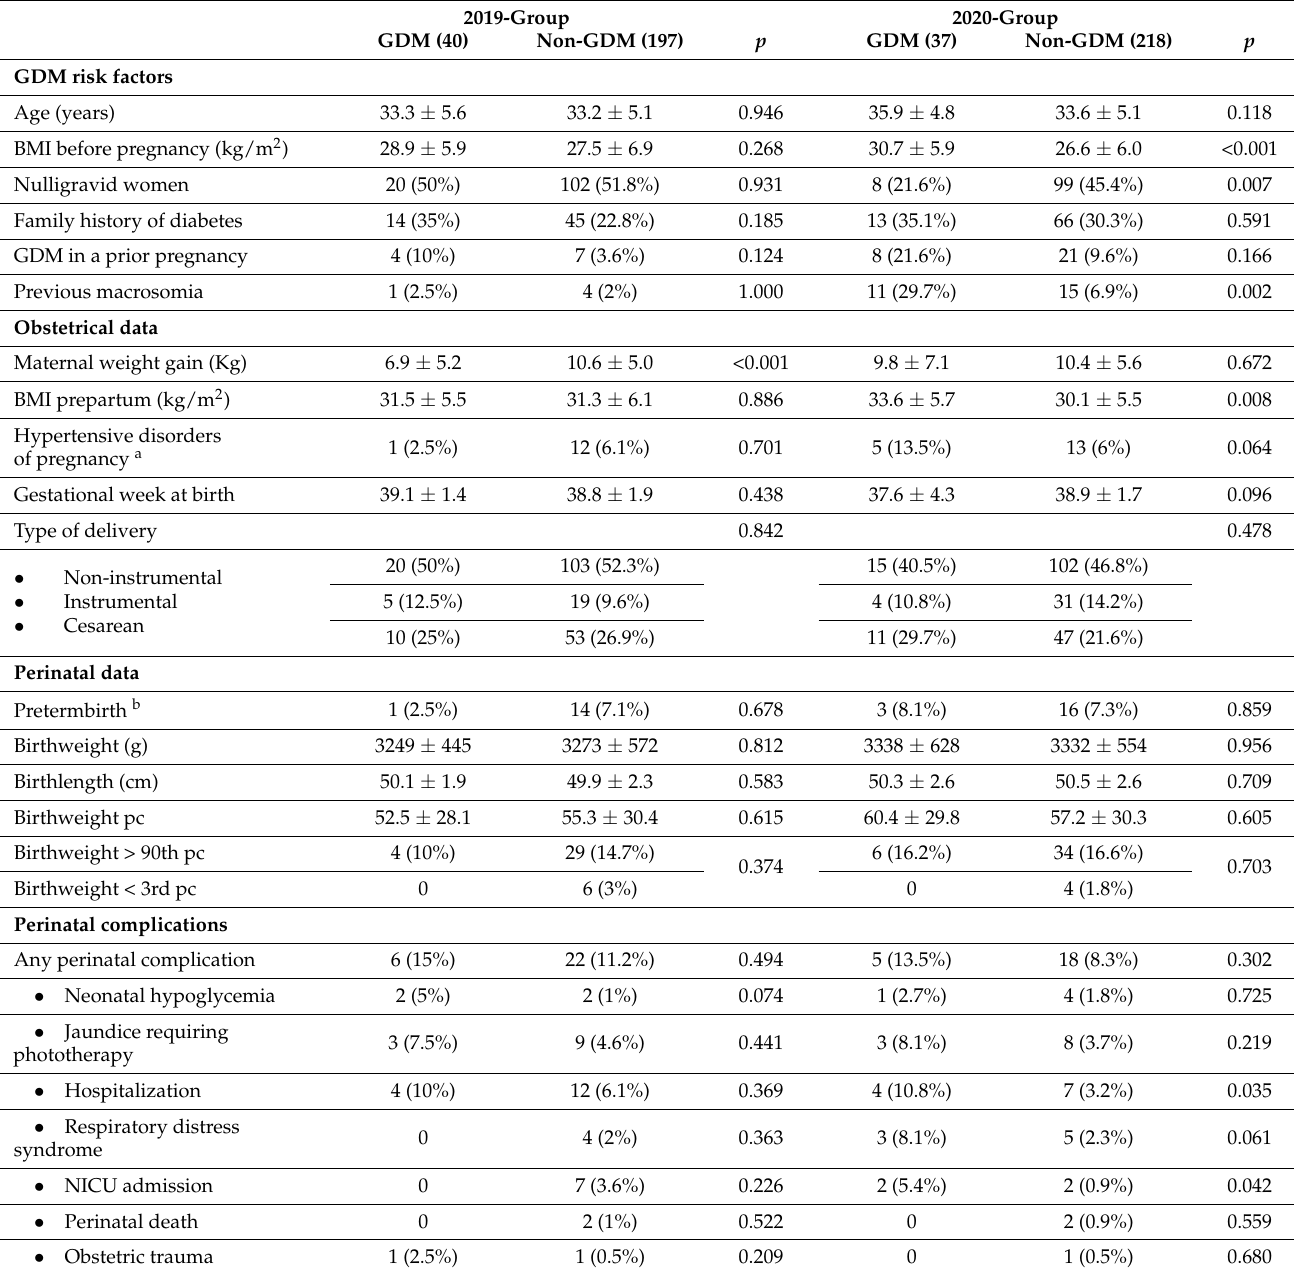
Table 1. Comparison between GDM vs. non-GDM women in 2019-group and 2020-group: GDM risk factors, obstetrical and perinatal